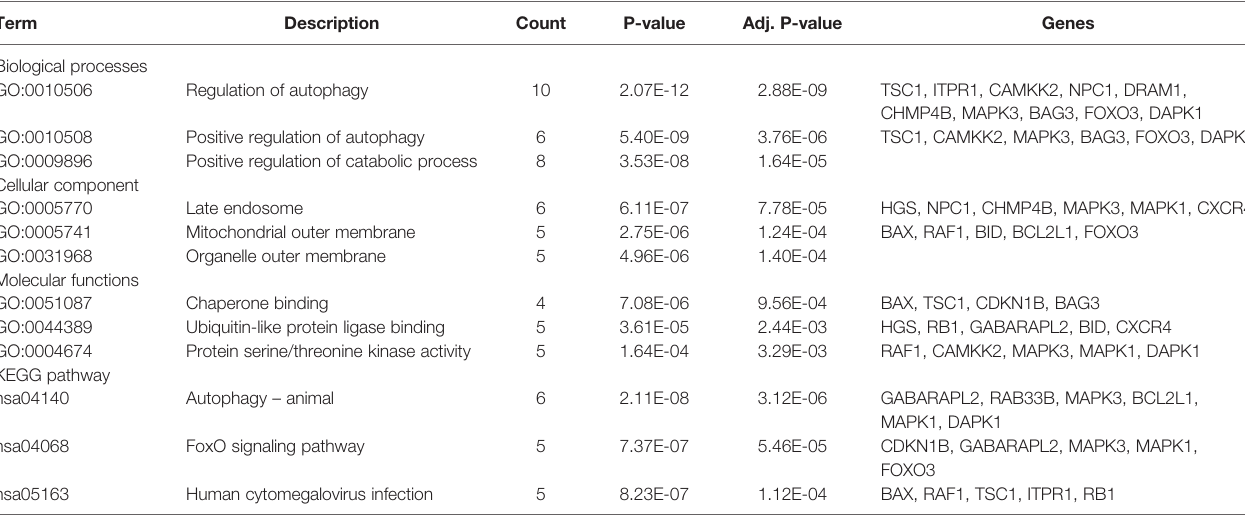
TABLE 3 | Functional and pathway enrichment analyses for module genes.